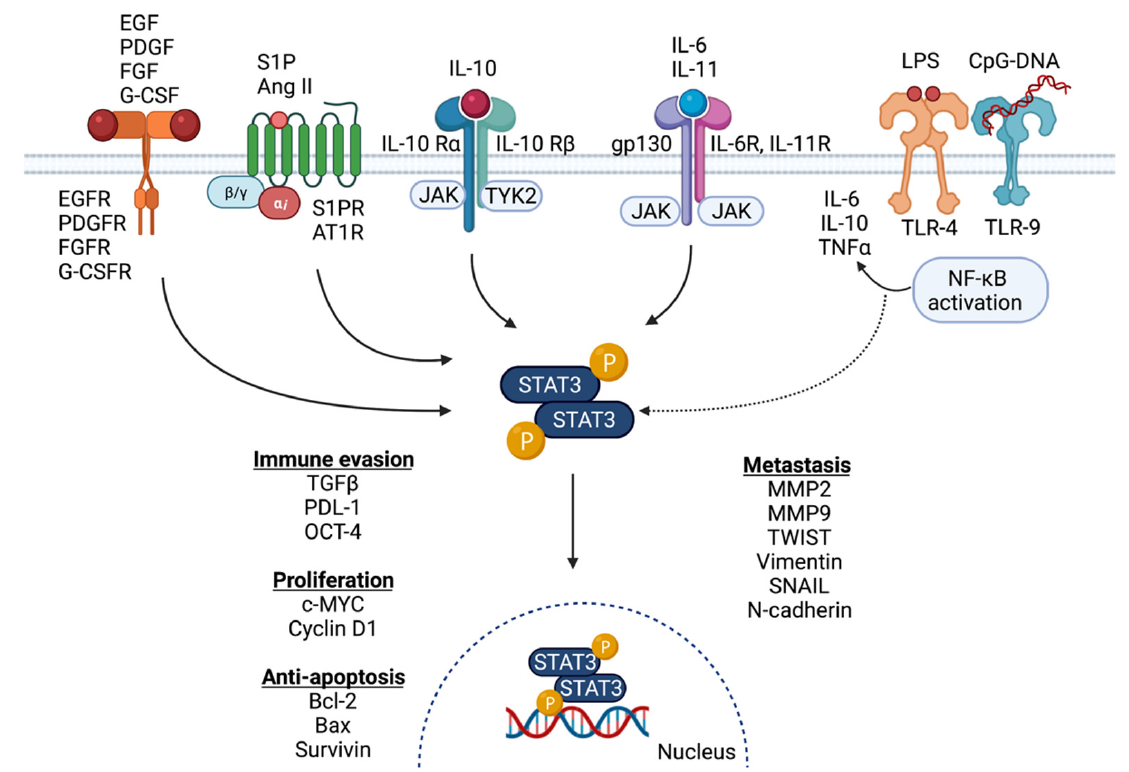
Figure 1. Activation, signaling partners and downstream targets of STAT3 in breast cancer. STAT3 is activated by cytokine signaling when IL-6 or IL-11 ligands bind to a hexameric receptor complex consisting of their specific receptor and gp130. This leads to a recruitment of JAK kinases to phosphorylate and activate STAT3, which dimerizes and translocates into the nucleus. Together with NF- κ B and GLI1, STAT3 activates transcription of a unique set of target genes which promote metastasis immune evasion, proliferation and resistance to apoptosis. Figure generated in Biorender (Available online: Biorender.com (accessed on 8 December 2021)).